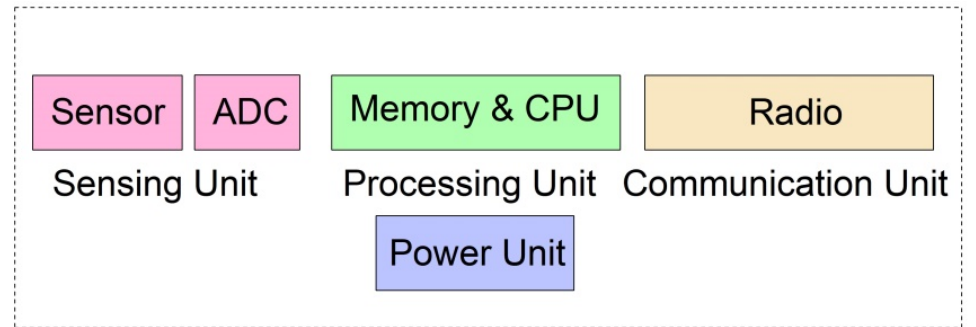
Figure 4. Sensor node structure.